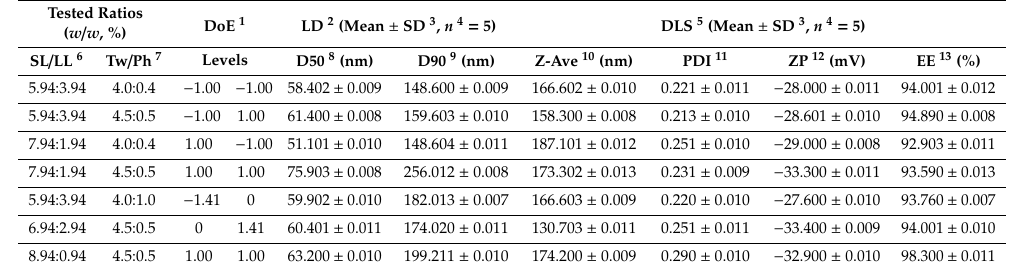
Table 4. Results of particle size (Z-Ave (mean particle size); volume distribution (50% of particles with size equal or lower to the given value of D50 and 90% of particles with diameter equal or lower to the given value of D90), polydispersity index (PDI), zeta potential (ZP), and encapsulation e ffi ciency (EE) tests for the rivastigmine-loaded nanostructured lipid carriers (NLC) selected following the optimization of formulation